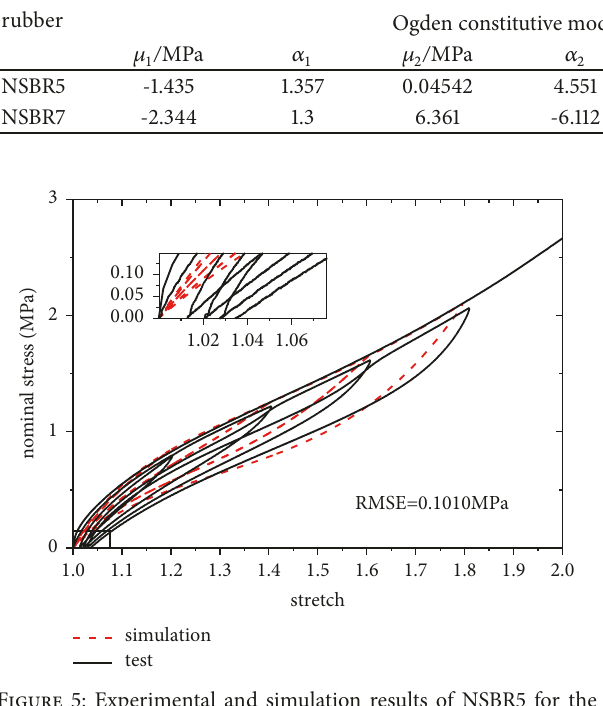
Figure 5: Experimental and simulation results of NSBR5 for the Mullins effect without the permanent set.